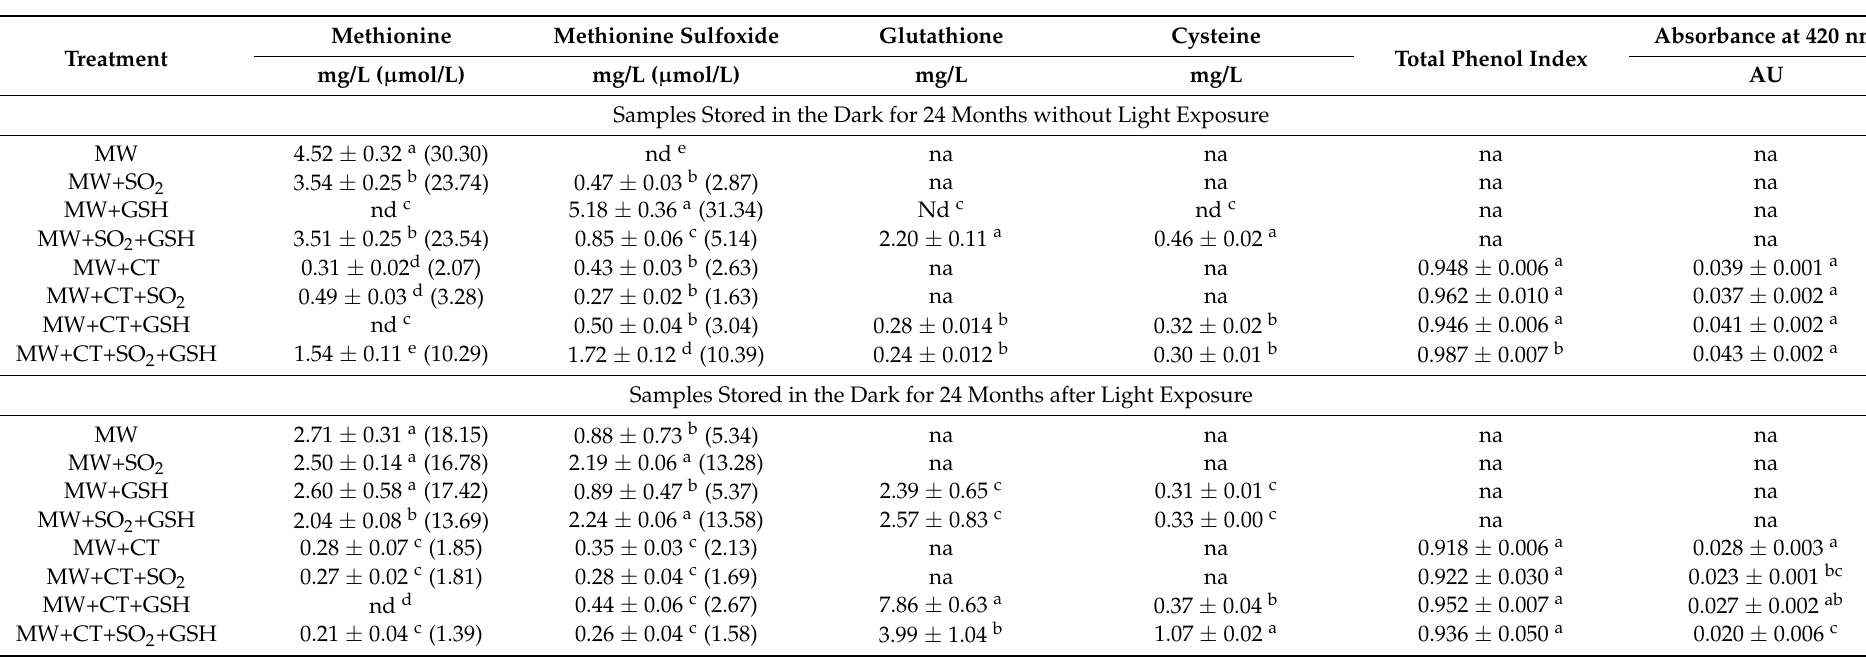
Table 1. Concentrations of methionine, methionine sulfoxide, glutathione, cysteine, total phenol index and absorbance at 420 nm determined in model wine solution (MW)